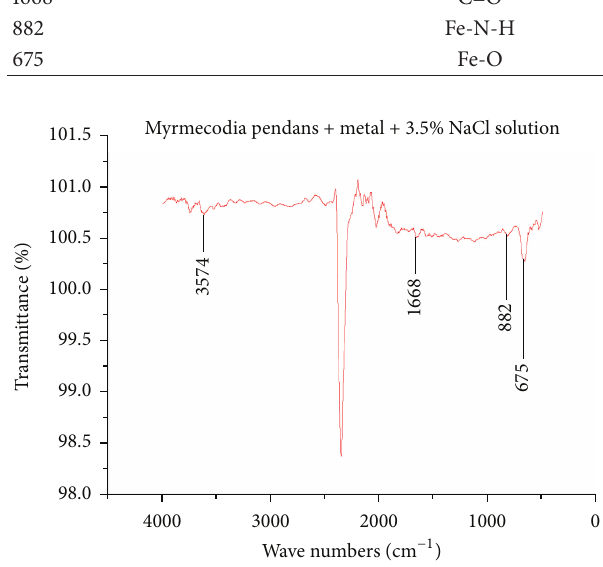
Figure 4: FTIR spectra of adsorption layer formed on the surface metal.